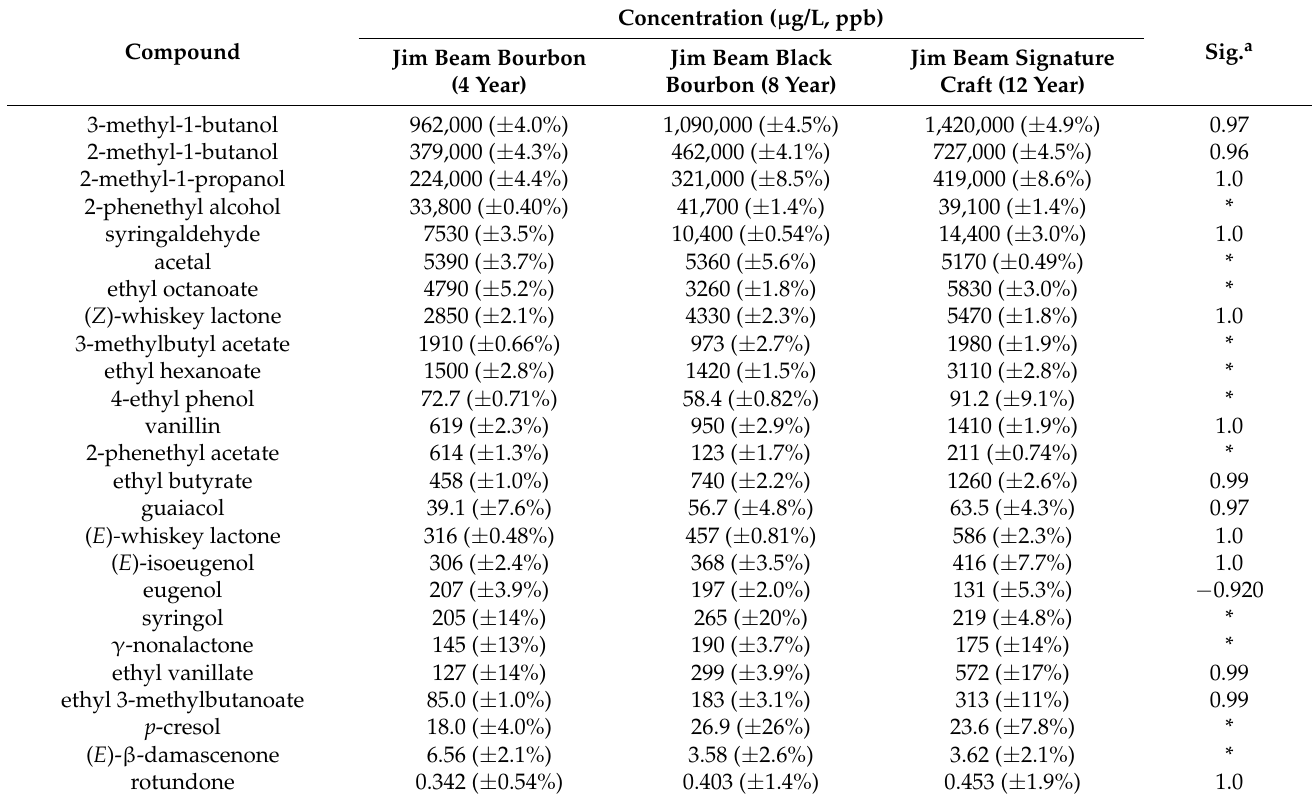
a For each row, values are coefficients of correlation (R), representing change in concentration of an odorant as a function of declared age; * indicates a significant difference ( p < 0.05), but no correlation exists with respect to change in odorant concentration as a function of declared